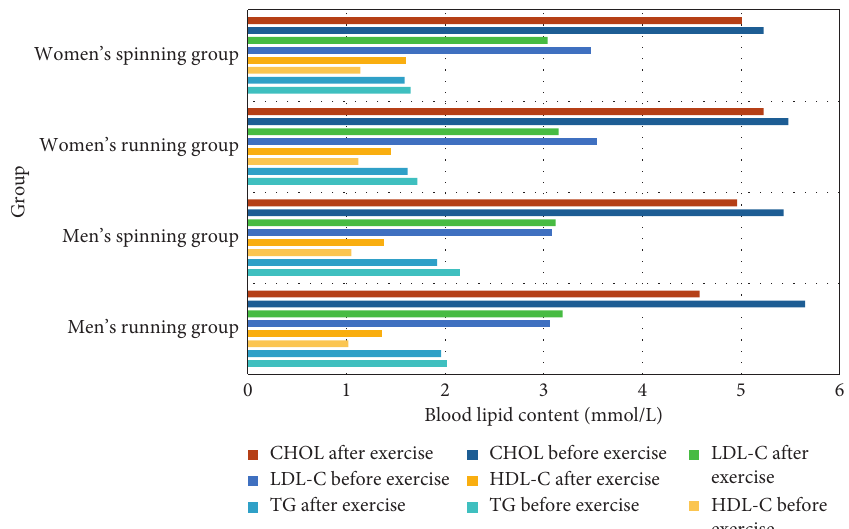
Figure 2: Changes in body composition of patients with dyslipidemia before and after exercise.